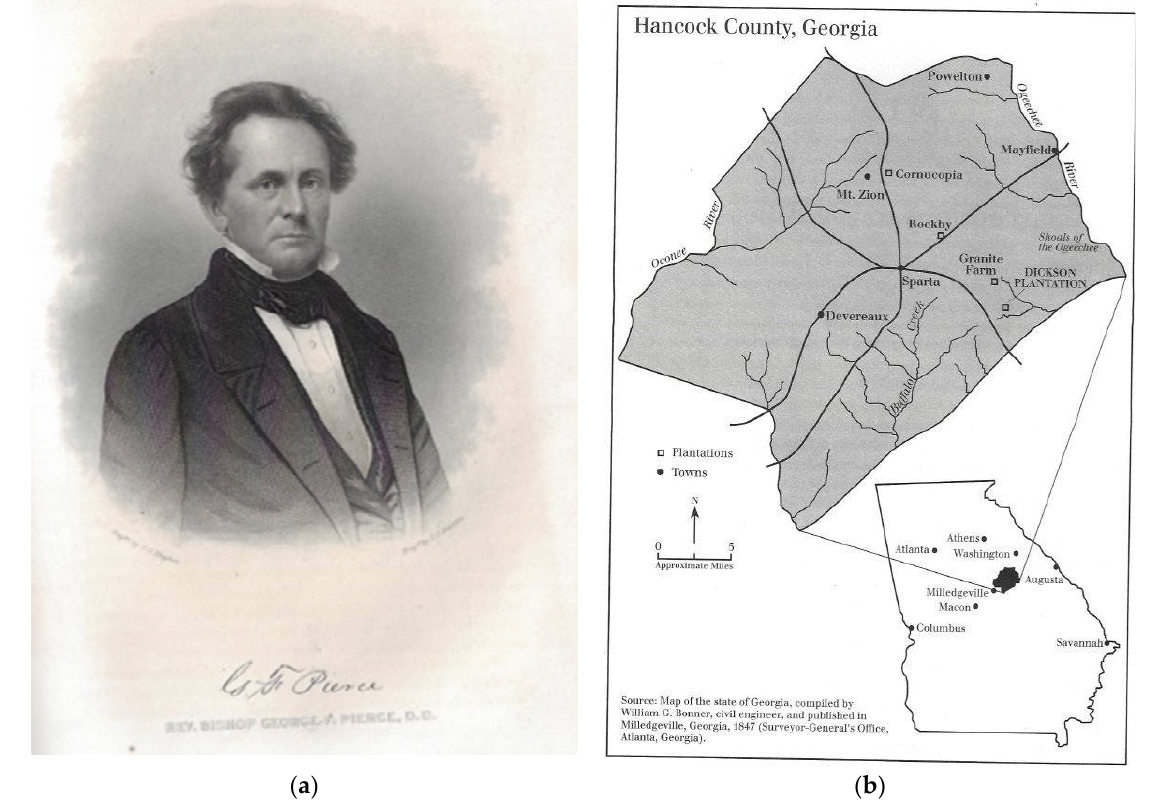
Figure 8. ( a ): Photograph of George Foster Pierce from The Life and Times of George Foster Pierce , published in 1888. ( b ): Map of Nineteenth Century Middle Georgia including Greene and Hancock Counties where George Foster Pierce lived most of his life. Image courtesy of Pierce, McClurkin, and Pierce, publication year unknown. Public Domain.